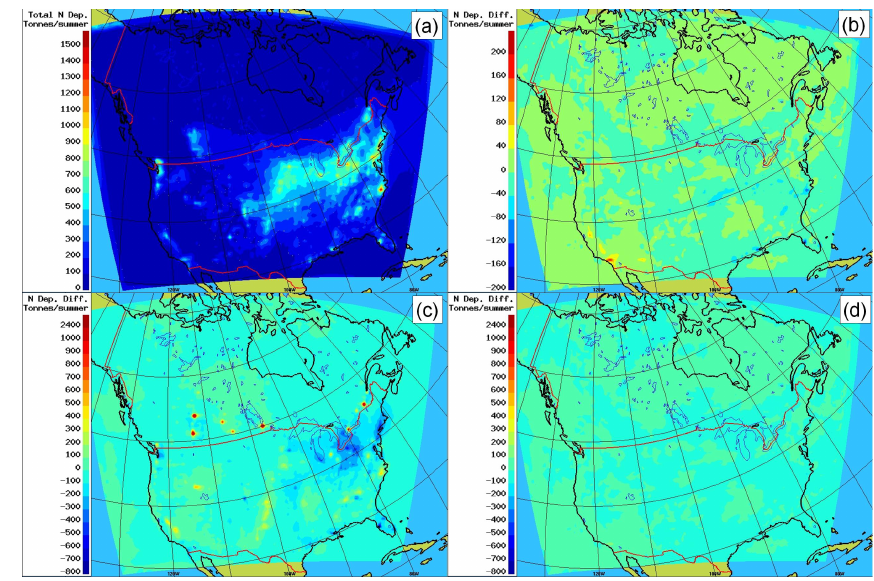
Fig. 15. Change in total deposition of N. Panels as in Fig. 7, for total N deposition, tonnes/summer.